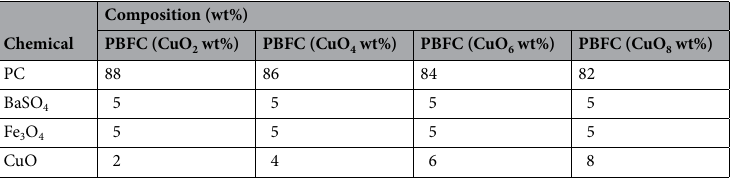
Table 1. Chemical weight compositions of concrete cement/BaSO 4 /Fe 3 O 4 /CuO material for various amount of CuO as an X-ray shielding.